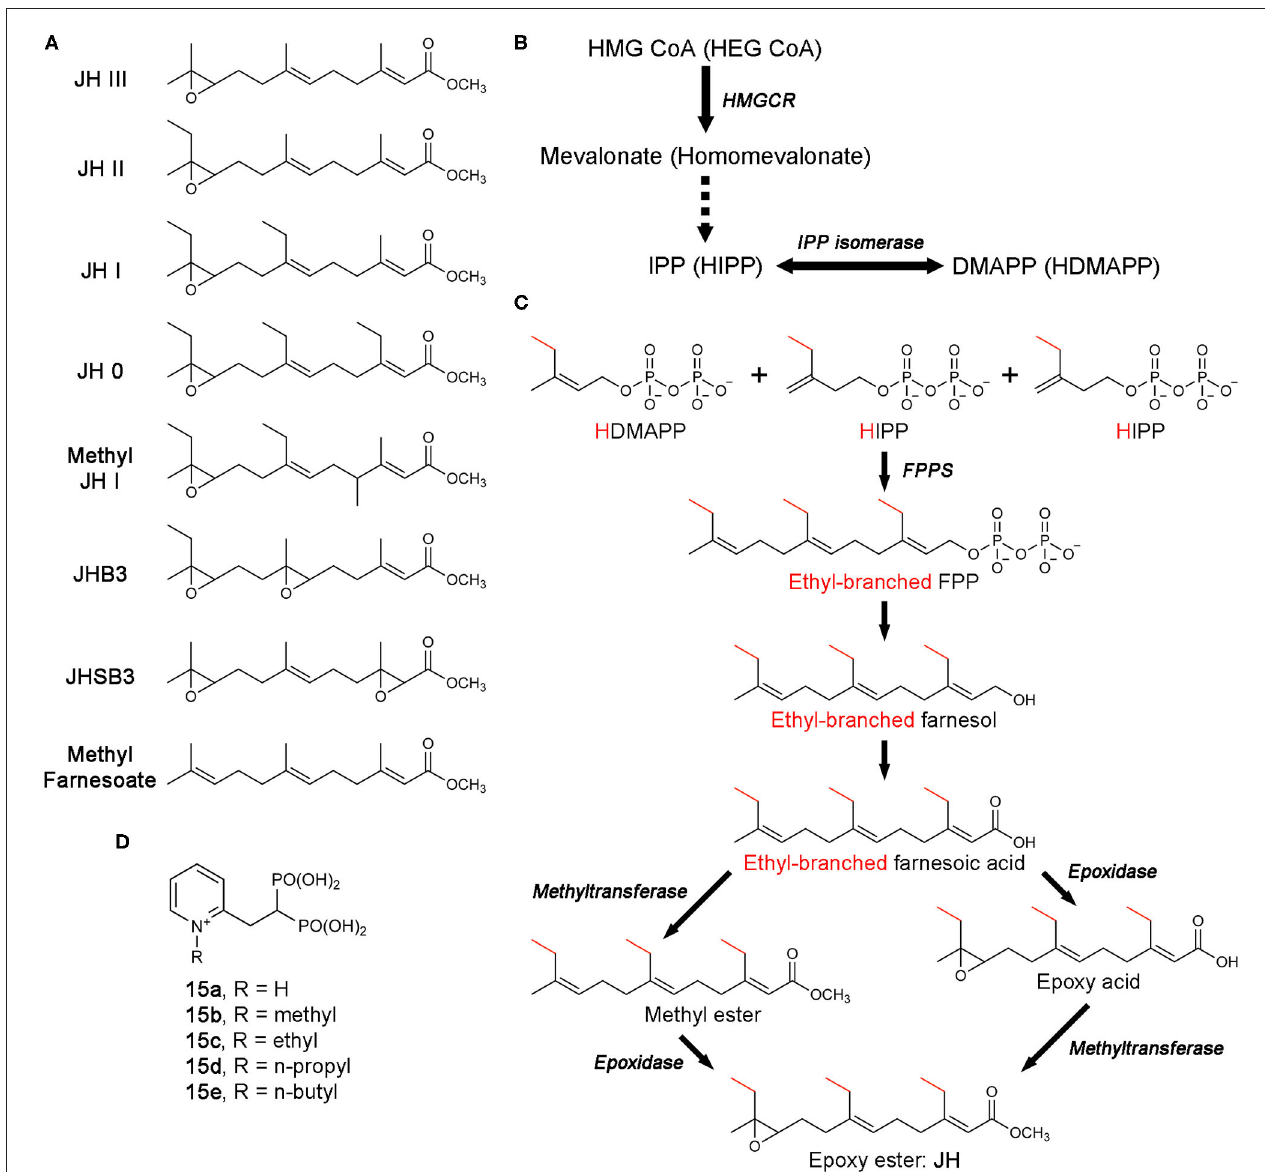
FIGURE 13 | Biosynthesis of juvenile hormones and bisphosphonate inhibitors of Cf FPPS2. (A) Molecular structures of juvenile hormones (JHs). (B) The MVA pathway and its promiscuous ethyl-branched metabolites (in brackets). The intermediate steps catalyzed sequentially by mevalonate kinase, phosphomevalonate kinase, and mevalonate pyrophosphate decarboxylase are omitted for simplicity (dotted arrow). Abbreviations: HEG CoA, hydroxylethylglutaryl coenzyme A; HIPP, homoisopentenyl pyrophosphate; HDMAPP, homodimethylallyl pyrophosphate. (C) The production of FPP/ethyl-branched analogs of FPP and their conversion to JH. Various combinations of the starting substrates lead to different forms of JH. For example, the condensation of HDMAPP with HIPP and IPP produces 7,11-bishomofarnesyl pyrophosphate, which is then converted to JH I. Notably, methyl farnesoate is the immediate precursor of JH III and lacks the epoxide moiety characteristic of JH. While there is a long-standing debate, the potential role of methyl farnesoate as a JH has been recognized. (D) N-alkylated ortho -substituted bisphosphonate inhibitors of Cf FPPS2.